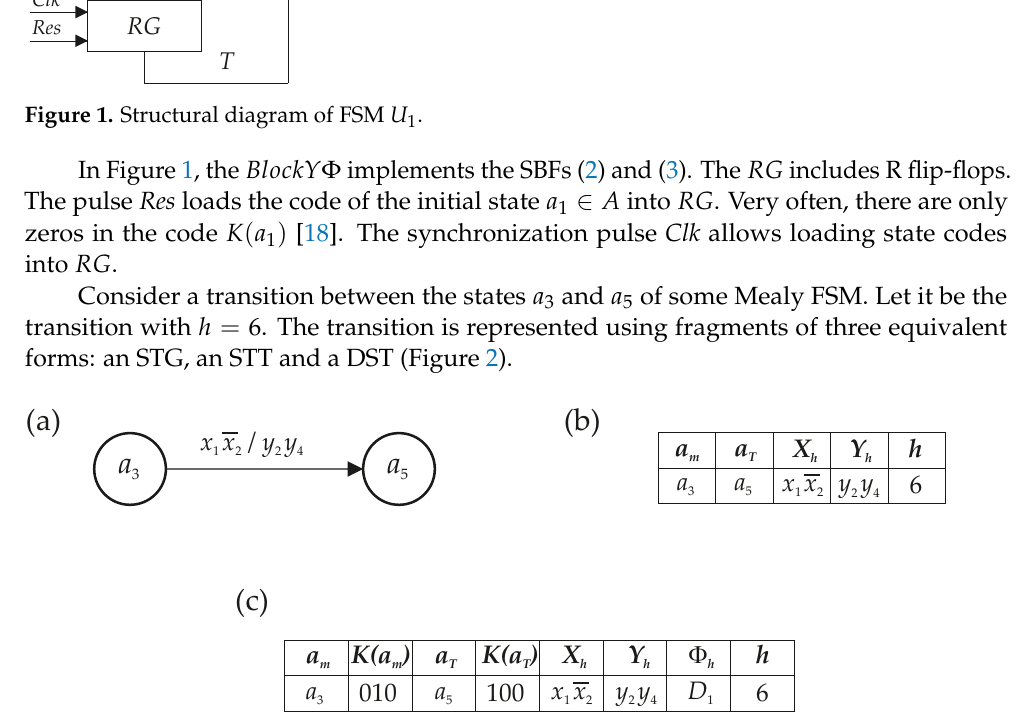
Figure 2. Equivalent fragments of STG ( a ), STT ( b ) and DST ( c